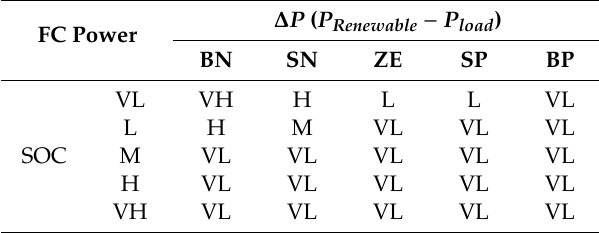
Table 1. Fuzzy rules of the microgrid Fuzzy Logic Energy Management System Table 1 . Fuzzy rules of the microgrid Fuzzy Logic Energy Management System (FLEMS)